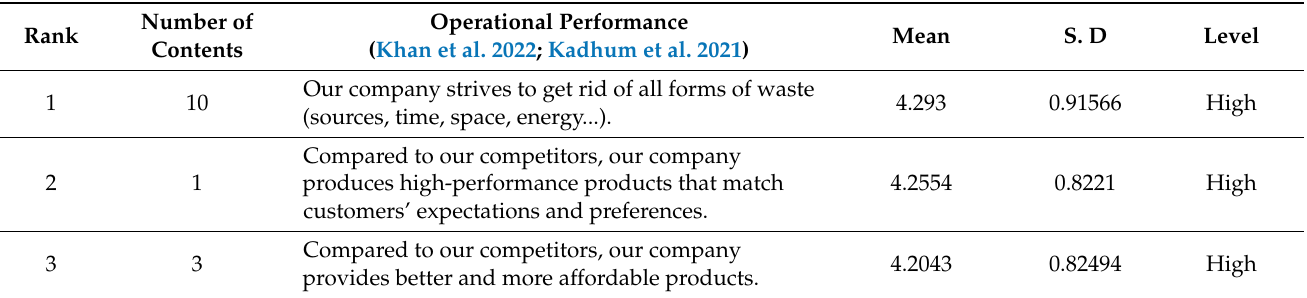
Table 5. Descriptive analysis—Operational performance items (N =